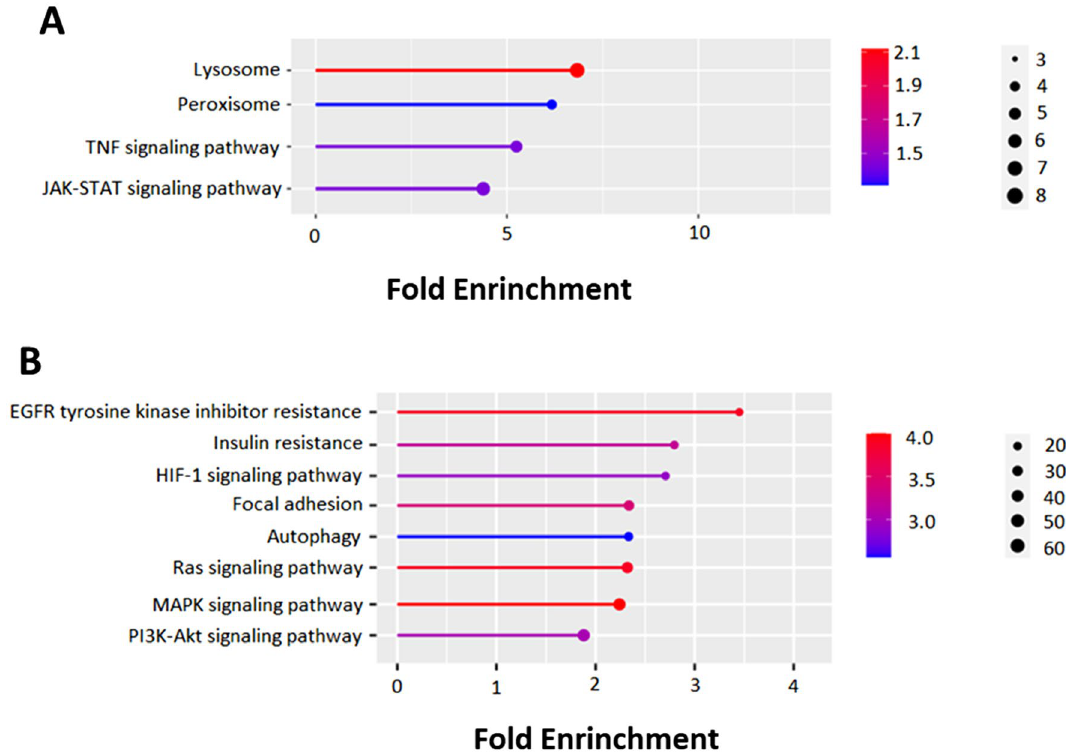
Figure 2. Pathway enrichment analysis of the target genes of upregulated ( A ) and downregulated ( B ) differentially expressed miRNA in subcutaneous adipose tissue of high-conditioned versus moderate- conditioned dairy cows on d 21 relative to calving annotated in Kyoto Encyclopedia of Genes and Genomes (KEGG) pathway using ShinyGO 0.76. The FDR is calculated based on the nominal P-value from the hypergeometric test. Fold Enrichment is defined as the percentage of genes in the uploaded list belonging to a pathway, divided by the corresponding percentage in the